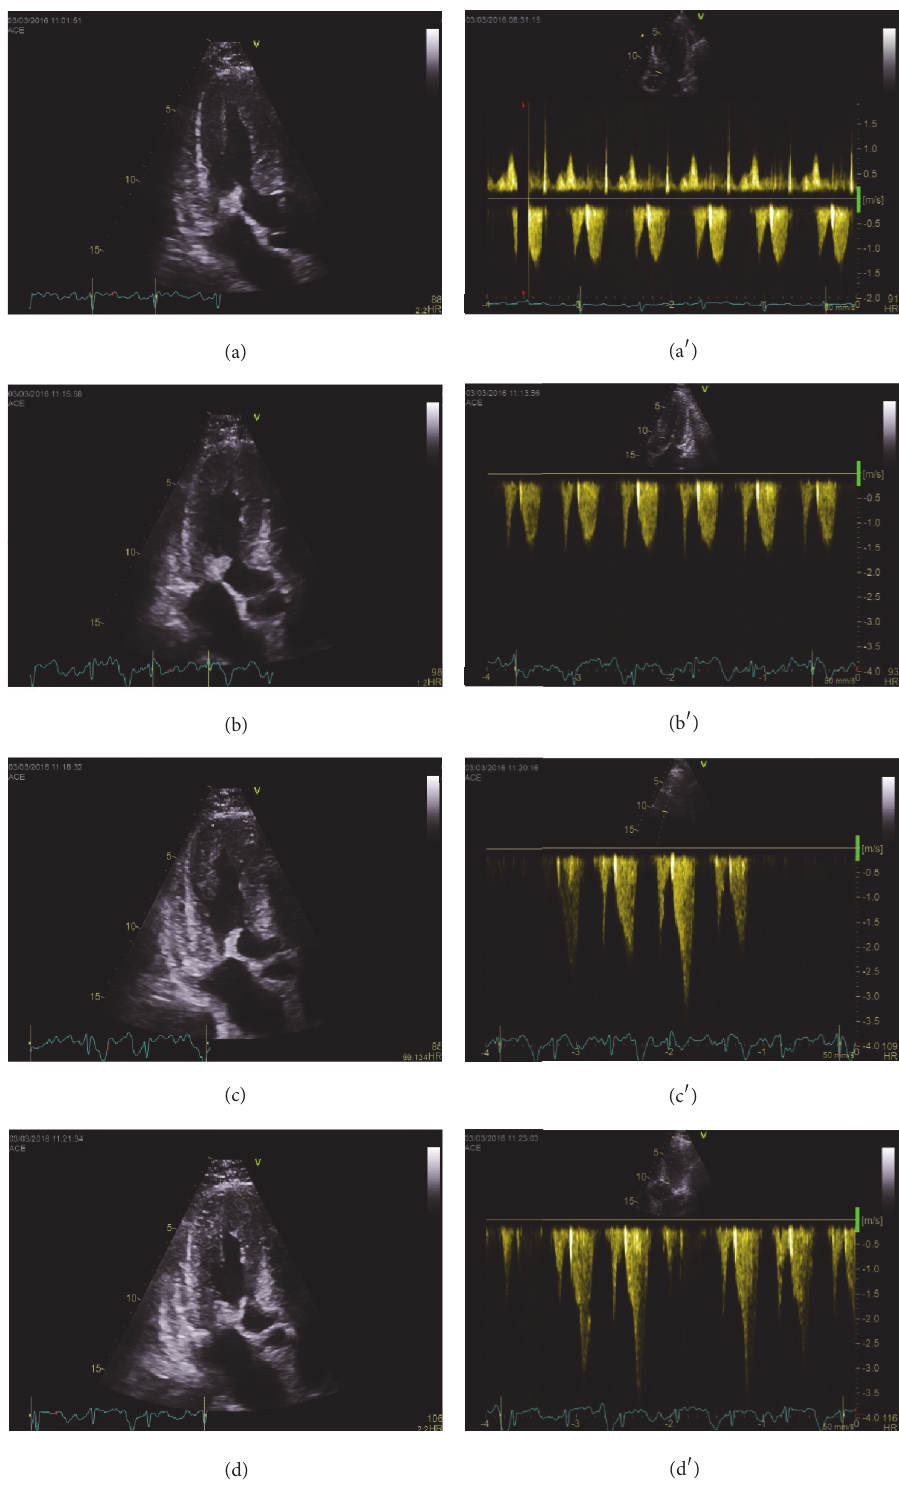
Figure 3: (a) Long-axis view at rest. (a 󸀠 ) Corresponding left ventricular outflow tract velocity. (b) Long-axis view at 10 Watts. (b 󸀠 ) Corresponding left ventricular outflow tract velocity. (c) Long-axis view at 30 Watts. (c 󸀠 ) Corresponding left ventricular outflow tract velocity. (d) Long-axis view at peak exercise. (d 󸀠 ) Corresponding left ventricular outflow tract